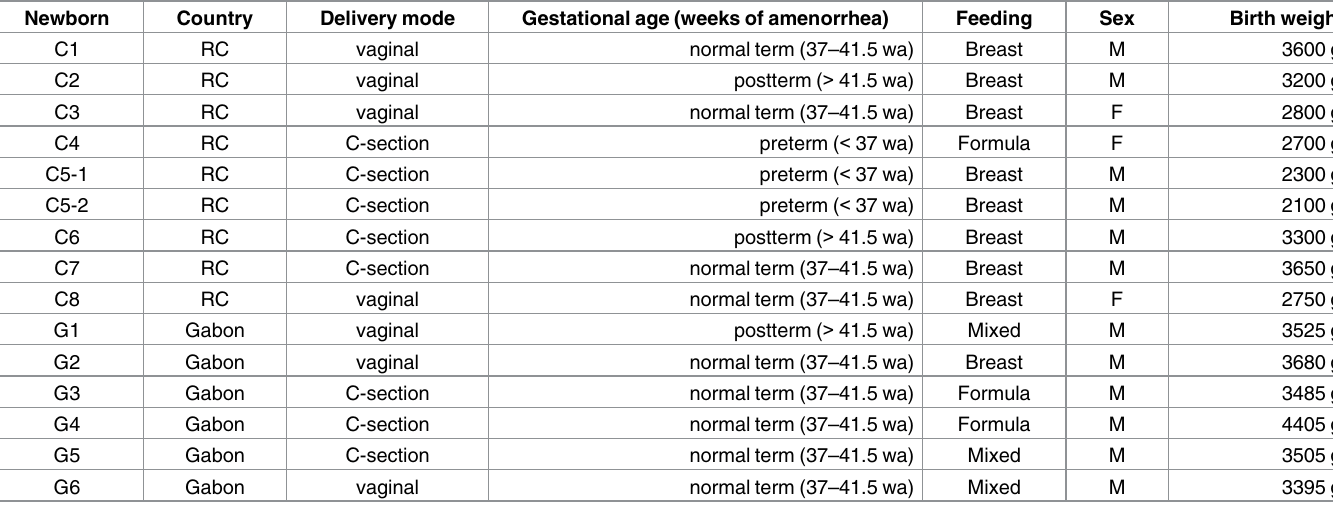
Table 1. Information on the children included in the study.